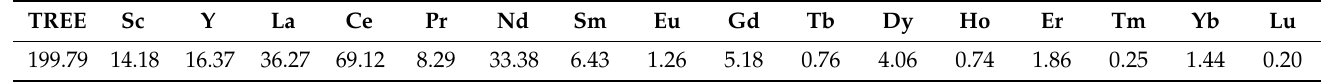
Table 1. REE concentrations for coarse waste determined by ICP-MS (mg/kg).